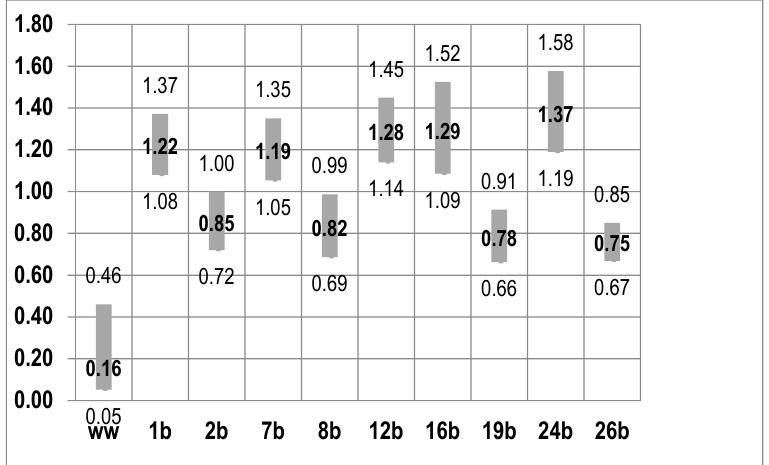
Figure 1. Factors determining weight loss: logistic regression based on the odds ratio +95%Cl;